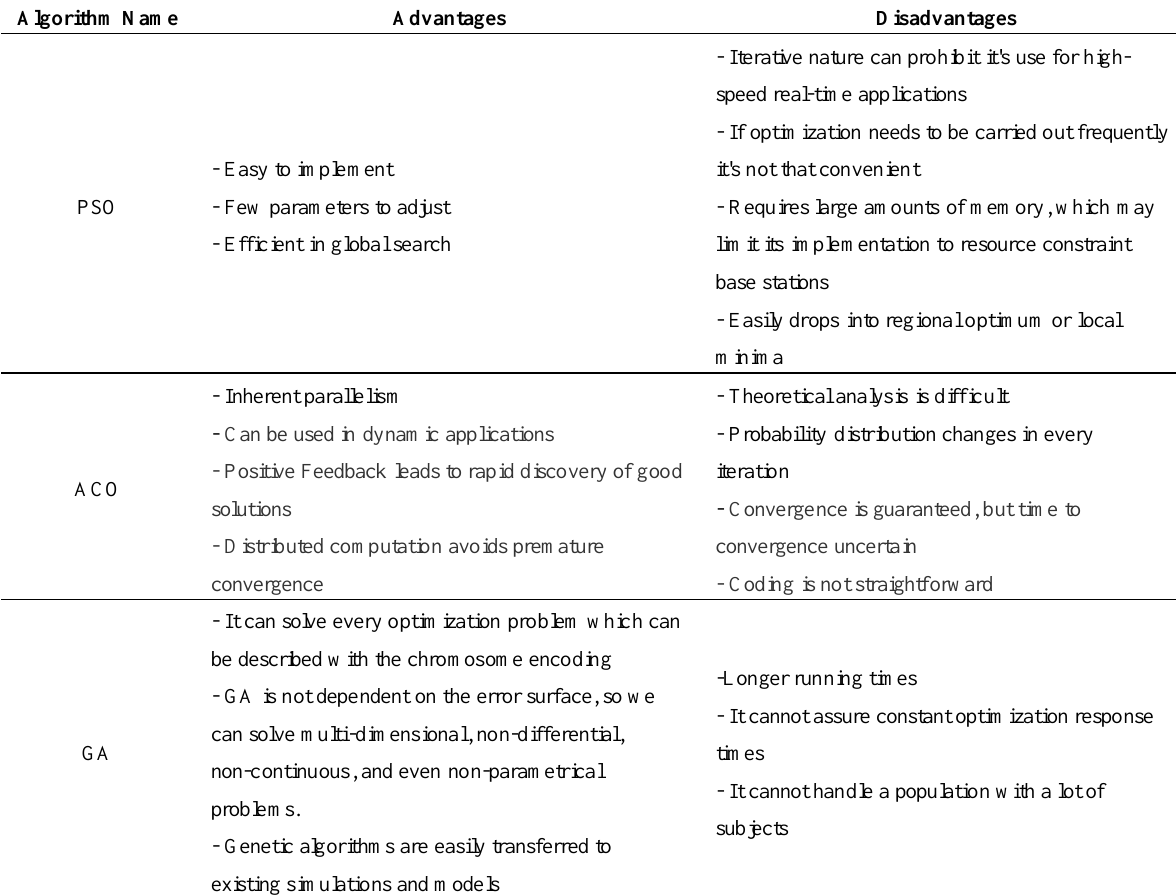
Table 3. Advantages and disadvantages of major bio-mimetic optimization